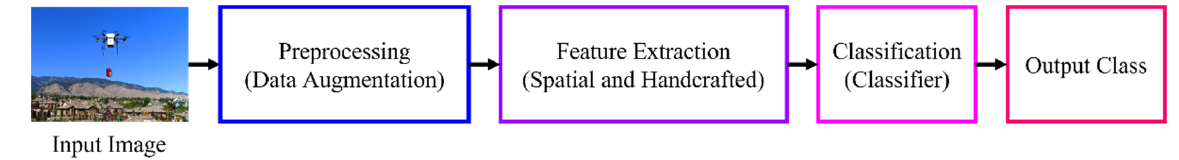
Figure 2. Flow diagram of the proposed methodology.